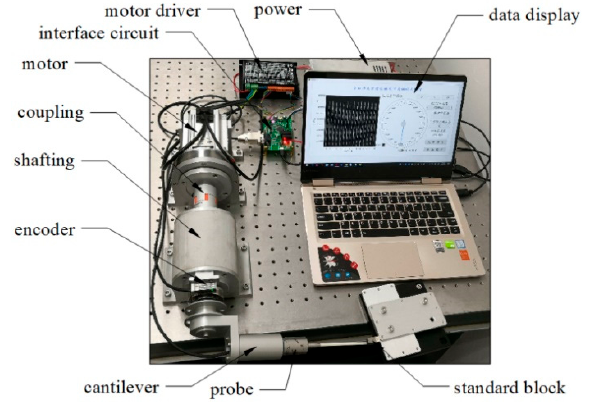
Figure 8. Experimental setup for a single joint [31].